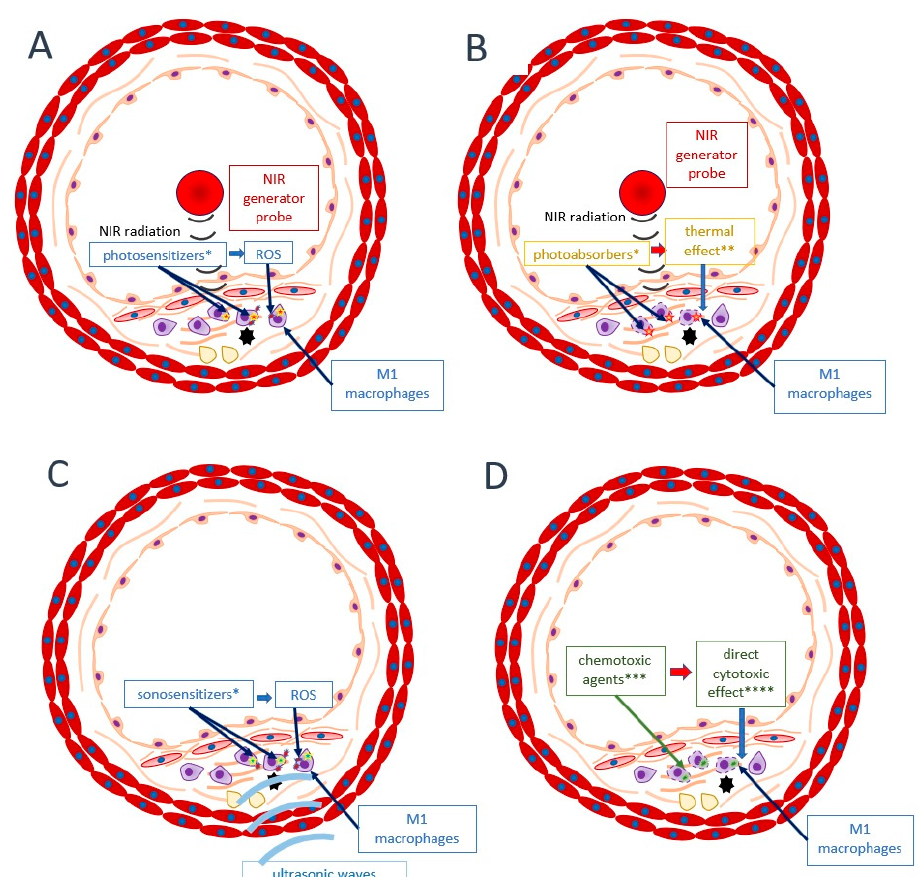
Figure 5. Alternative approaches towards atherosclerotic plaque stabilization targeted at concretely already developed vulnerable plaques. ( A ) photodynamic therapy (PDT); ( B ) plasmonic photothermal therapy (PPTT); ( C ) sonodynamic therapy; ( D ) cytotoxic chemotherapy. * photosensitizer, photoabsorber, or sonosensitizer previously injected into the organism, then accumulated within plaque macrophages; ** effects inducing apoptosis or other forms of cellular death; *** chemotoxic agents encapsulated in nanoformulas and targeted specifically to macrophages; **** apoptosis, necrosis, necroptosis. ROS: reactive oxygen species; NIR: near ‐ infrared.